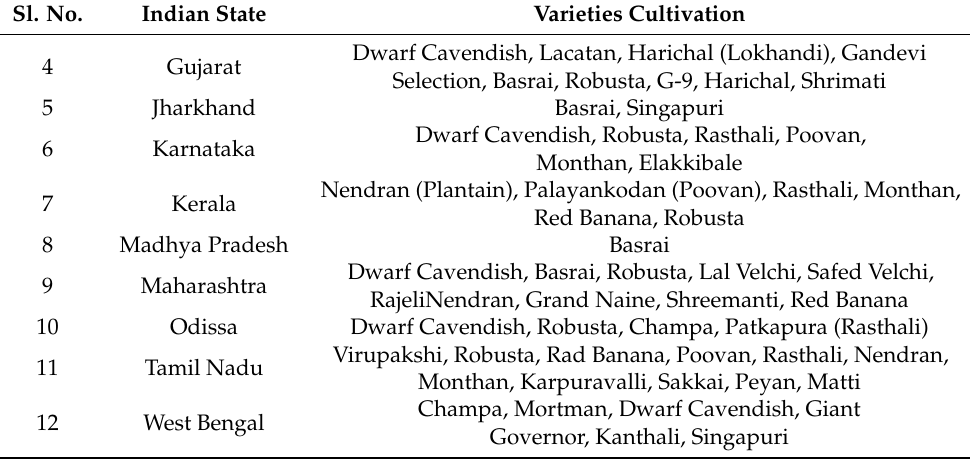
Table 1. Cont. Sl.